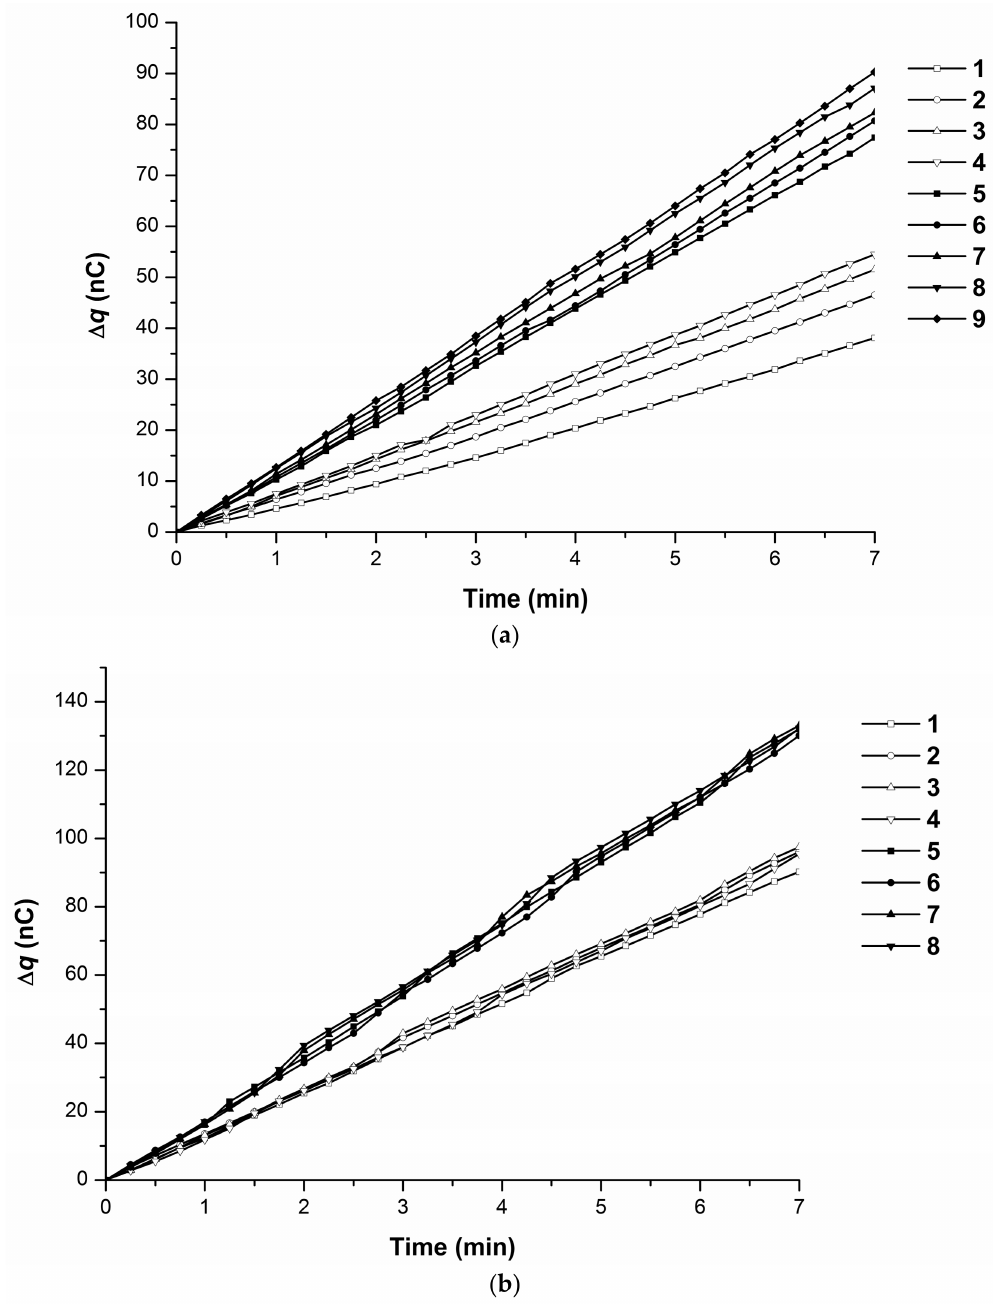
Figure 4. Typical ∆ q(t) dependencies obtained in the absence (white markers) and in the presence (dark markers) of an electric field for water ( a ) and protein solution ( b ) at 38 ◦ C. The data of one and the same experimental series obtained using one and the same tube-pipe-tip set (see “Materials and Methods” section) are